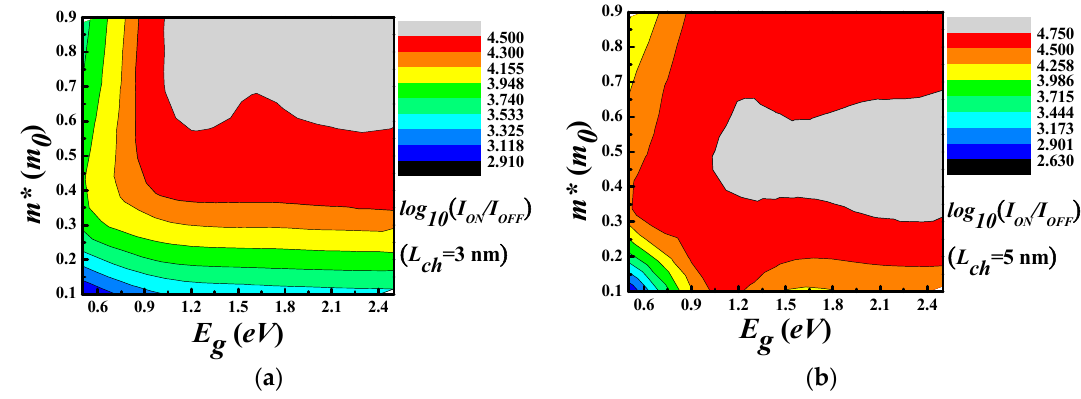
Figure 4. The (cid:1835) (cid:3016)(cid:3015) (cid:1835) (cid:3016)(cid:3007)(cid:3007) ⁄ of devices with di ff erent channel length ( a ) (cid:1838) (cid:3030)(cid:3035) = 3 nm and ( b ) (cid:1838) (cid:3030)(cid:3035) = 5 nm Figure 4. The I ON / I OFF of devices with different channel length ( a ) L ch = 3 nm and ( b ) L ch = 5 nm as as a function of bandgap and e ff ective mass. a function of bandgap and effective